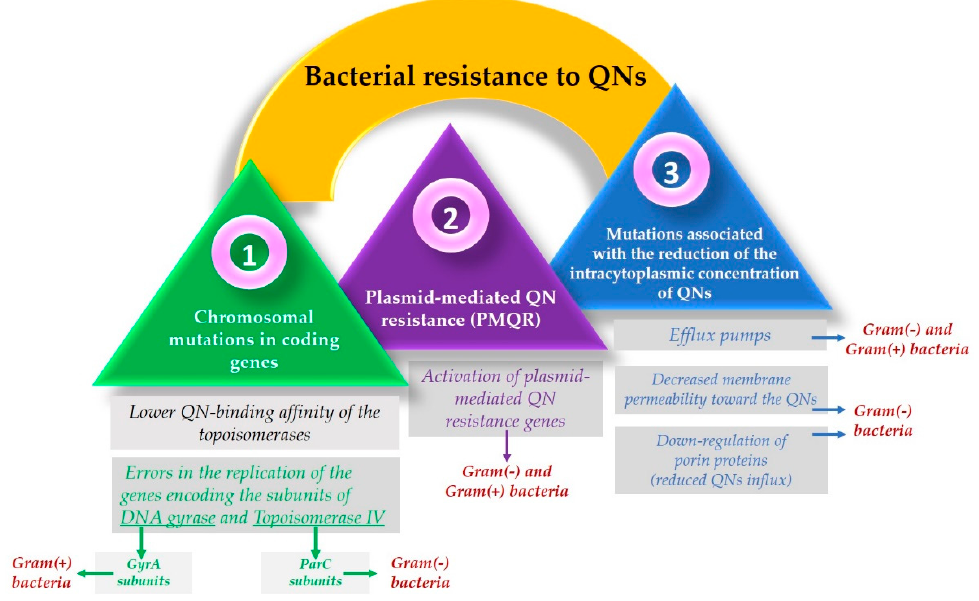
Figure 5. The main bacterial resistance mechanisms to QNs